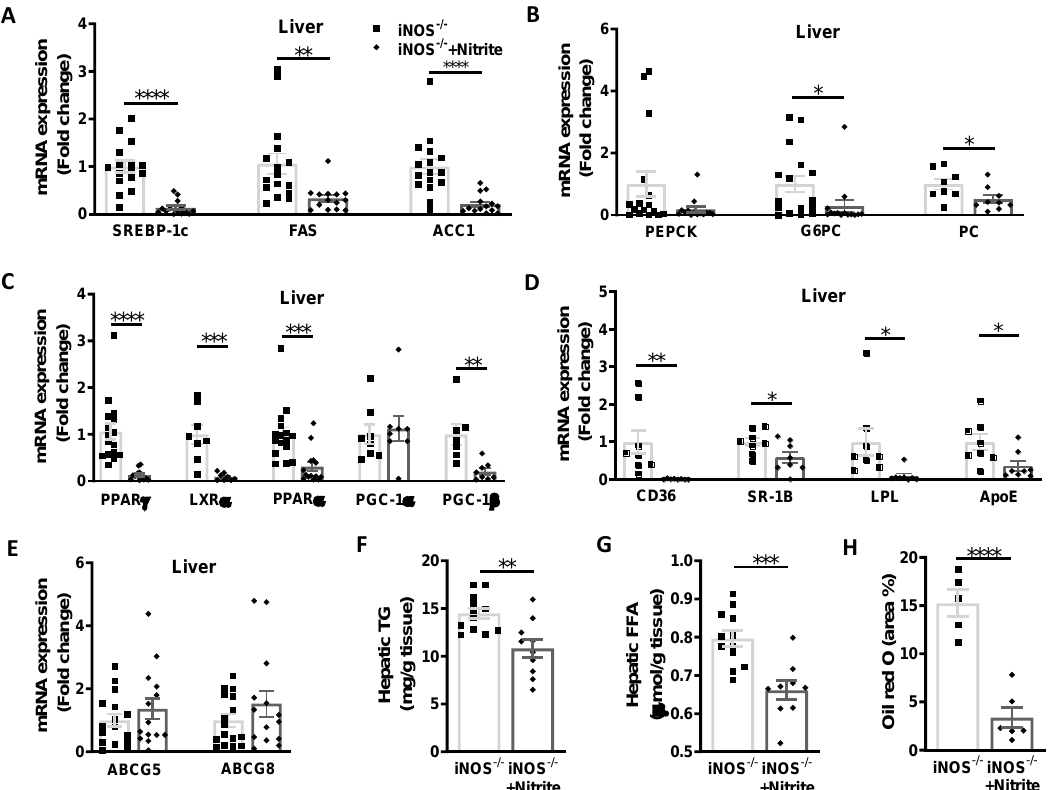
Figure 4. Metabolic homeostasis in liver of chow fed iNOS − / − mice with and without nitrite supplementation. ( A ) qPCR expression of genes involved in lipid synthesis (iNOS − / − : n = 16, iNOS − / − + Nitrite: n = 14): SREBP-1c, FAS, and ACC1. ( B ) qPCR expression of genes involved in gluconeogenesis (iNOS − / − : n = 16, iNOS − / − + Nitrite: n = 14): PEPCK, G6PC, and PC ( n = 8). ( C ) qPCR expressions of transcriptional regulators involved in lipid synthesis: PPARy (iNOS − / − : n = 16, iNOS − / − + Nitrite: n = 14) and LXR α ( n = 8) and genes involved in fatty acids oxidation: PPAR α (iNOS − / − : n = 16, iNOS − / − + Nitrite: n = 14), PGC-1 α , and PGC-1 β ( n = 8). ( D ) qPCR expression of genes involved in lipid uptake ( n = 8): CD36, SR-B, ApoE, and LPL. ( E ) qPCR expression of genes involved in lipid efflux (iNOS − / − : n = 16, iNOS − / − + Nitrite: n = 14): ABCG5 and ABCG8. Lipid accumulation in liver, ( F ) hepatic triglycerides (iNOS − / − : n = 12, iNOS − / − + Nitrite: n = 10), ( G ) hepatic free fatty acids (iNOS − / − : n = 12, iNOS − / − + Nitrite: n = 10), and ( H ) hepatic Oil red O staining (iNOS − / − : n = 5, iNOS − / − + Nitrite: n = 6) in chow fed iNOS − / − mice with or without nitrite supplementation. Data are represented as mean ± SEM. Black squares: iNOS − / − mice without nitrite supplementation, black diamonds: iNOS − / − mice with nitrite supplementation. * p < 0.05, ** p < 0.01, *** p < 0.001, **** p < 0.0001 vs. iNOS − / − .